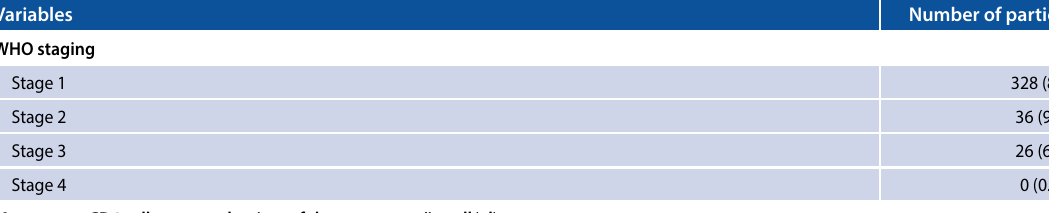
Table 3: Clinical characteristics of the study’s participants